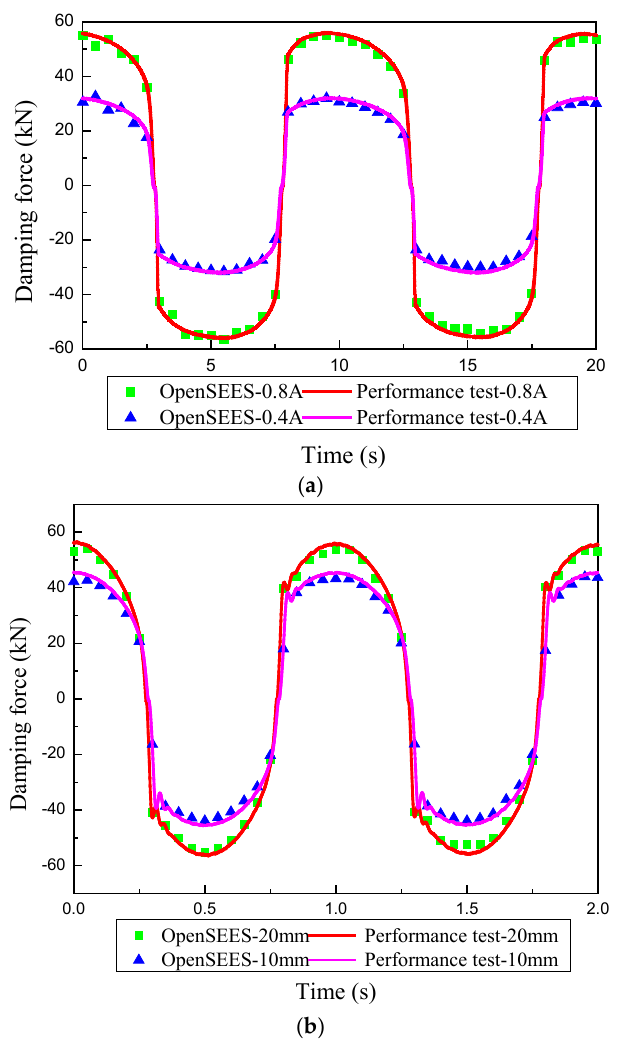
Figure 9. Comparisons between the damping force calculated from OpenSEES and performance test results. ( a ) 0.1 Hz, 20 mm. ( b ) 1.0 Hz, 0.4 A.